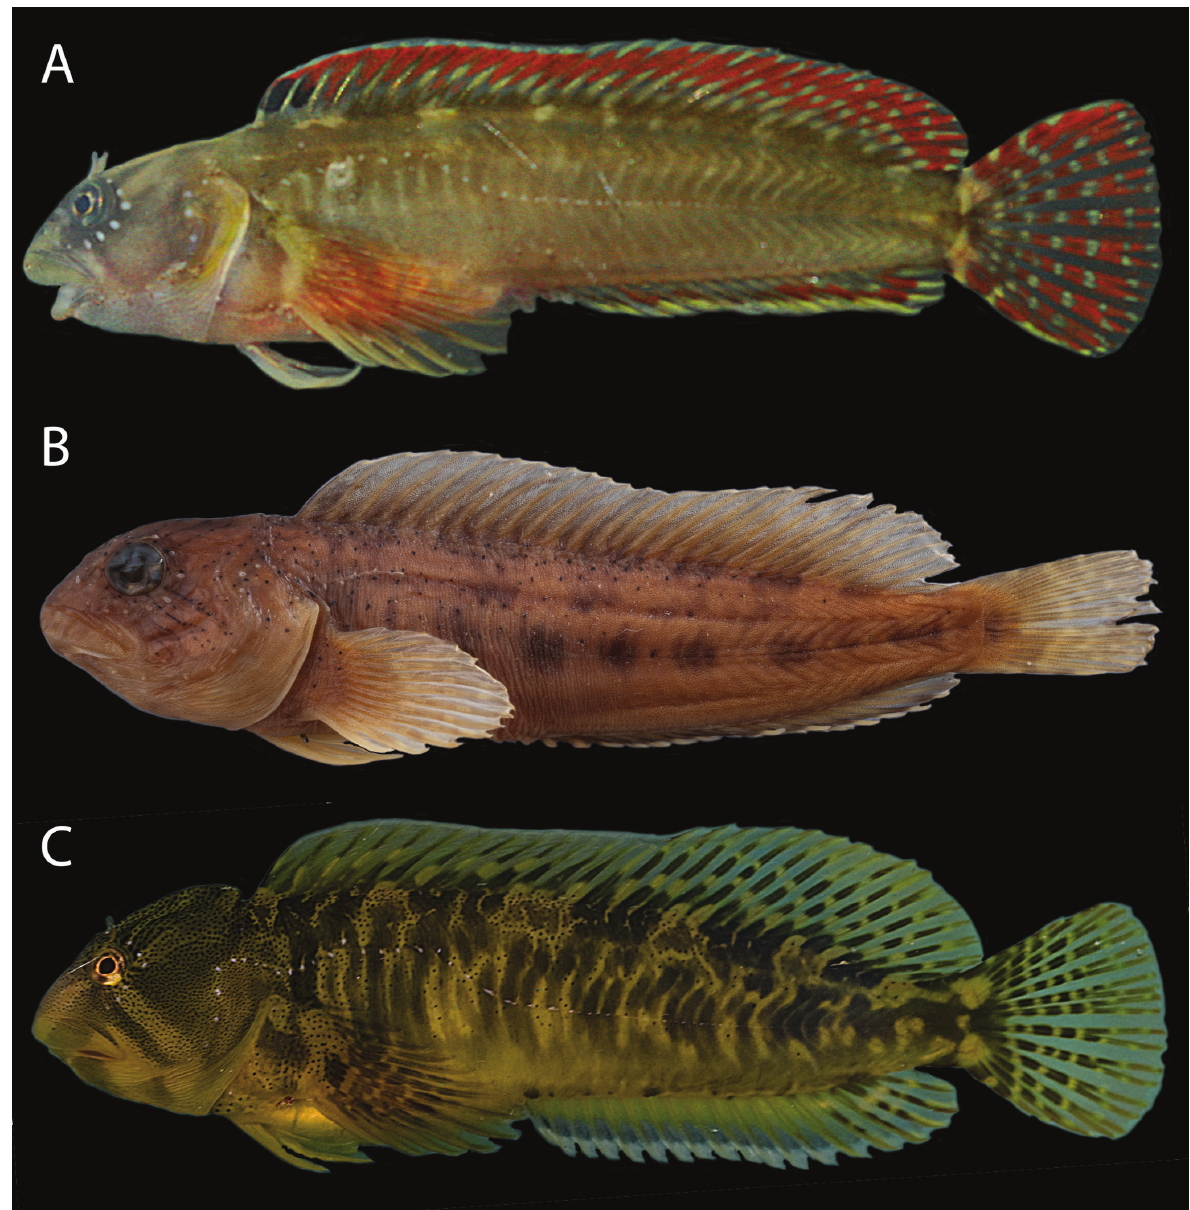
Figure 1. Lateral view of Ichthyocoris spp.: I. atlantica , MNCN 280135, 61 mm SL, Morocco, Ouerrha River (Sebou drainage) at Ouazzane ( A ; photo credits: I. Doadrio); I. economidisi , MHNG 2641.89, holotype, 60.8 mm SL, Greece, Lake Trichonis east of Panetolio ( B ; photo credits: R. Covain); I. fluviatilis , 89 mm SL, Spain, Jerea River (Ebro drainage) at Virués ( C ; photo credits: I.